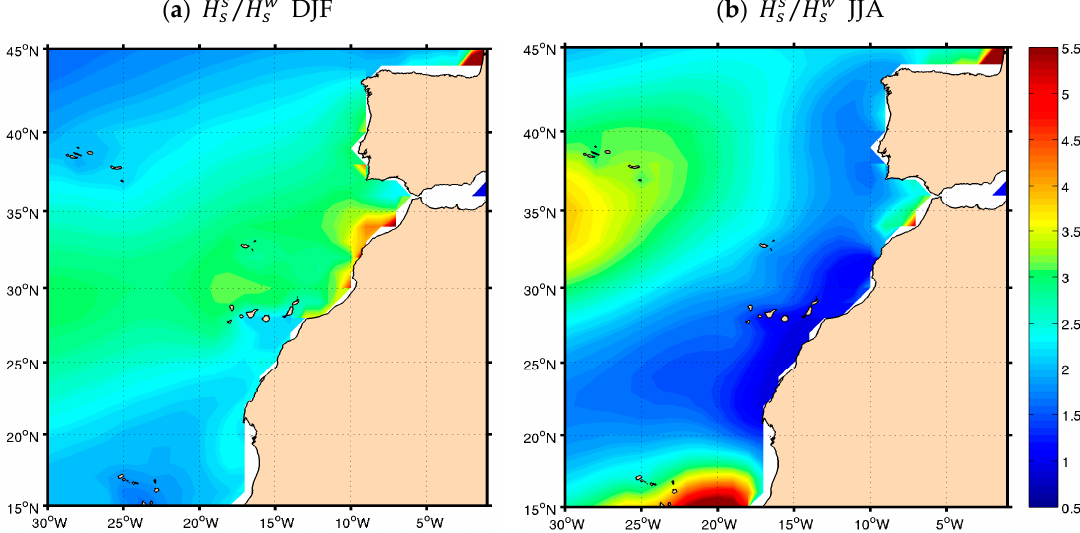
Figure 7. Climatological distribution of the H s s / H w s index (dimentionless), for ( a ) DJF and ( b )